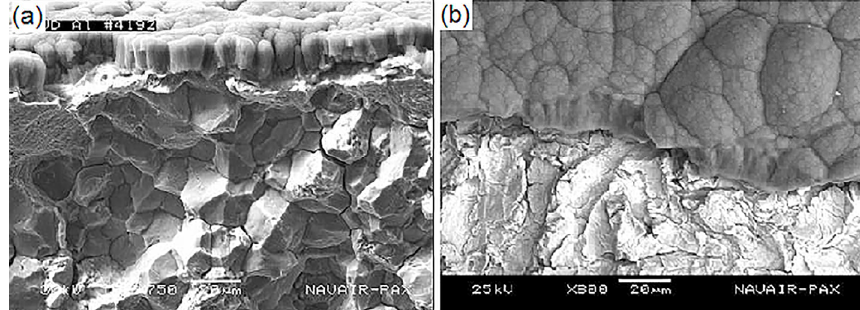
Fig. 9 The fracture image of (a) ion vapour deposited Al coating showing a columnar-like structure (top of the image), and (b) non-aqueous electroplated Al coating and exposed substrate. Reproduced with permission from Ref. [24], Licensed under Distribution Statement A, 2011.